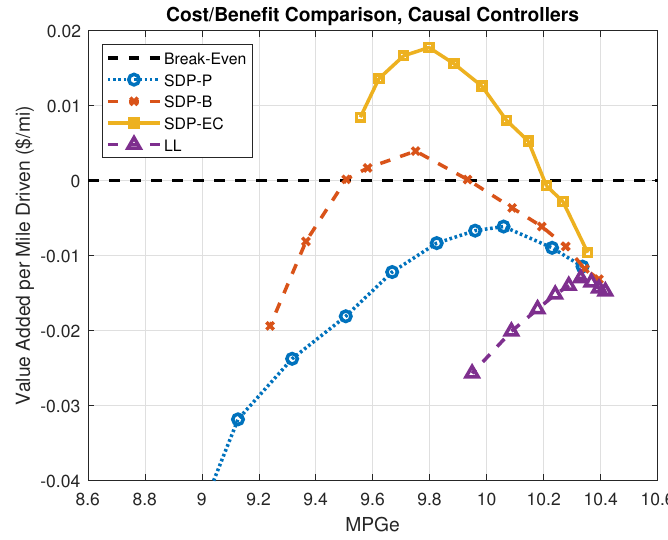
Figure 14. Cost-benefit analysis for the four causal control methods, N pc = 100. Finally, the estimated payback time is computed for the maximum benefit of the SDP-EC method for all three cases using Equation (62). It is found that, for the given UC, battery, and energy costs, the small HESS ( N pc = 10) has a payback time of 11.3 years, the mid-sized HESS ( N pc = 10) has a payback time of 15.6 years, and the large HESS ( N pc = 100) has a payback time of 21.6 years. In order to observe the full trend of the payback period for different ultracapacitor sizes, additional simulations are run for N pc equal to 2, 5, and all increments of 10 between 10 and 100. The optimal EMS and optimal Q 2, SOC are recomputed and the vehicle is simulated again for the new EMS and new UC size. The payback time and battery lifespan at the most cost-effective tuning for each N pc are then plotted in Figure 15. This shows that, although increasing the HESS does does improve the battery lifespan, the cost of the extra UCs exceeds the savings of that extra lifespan.